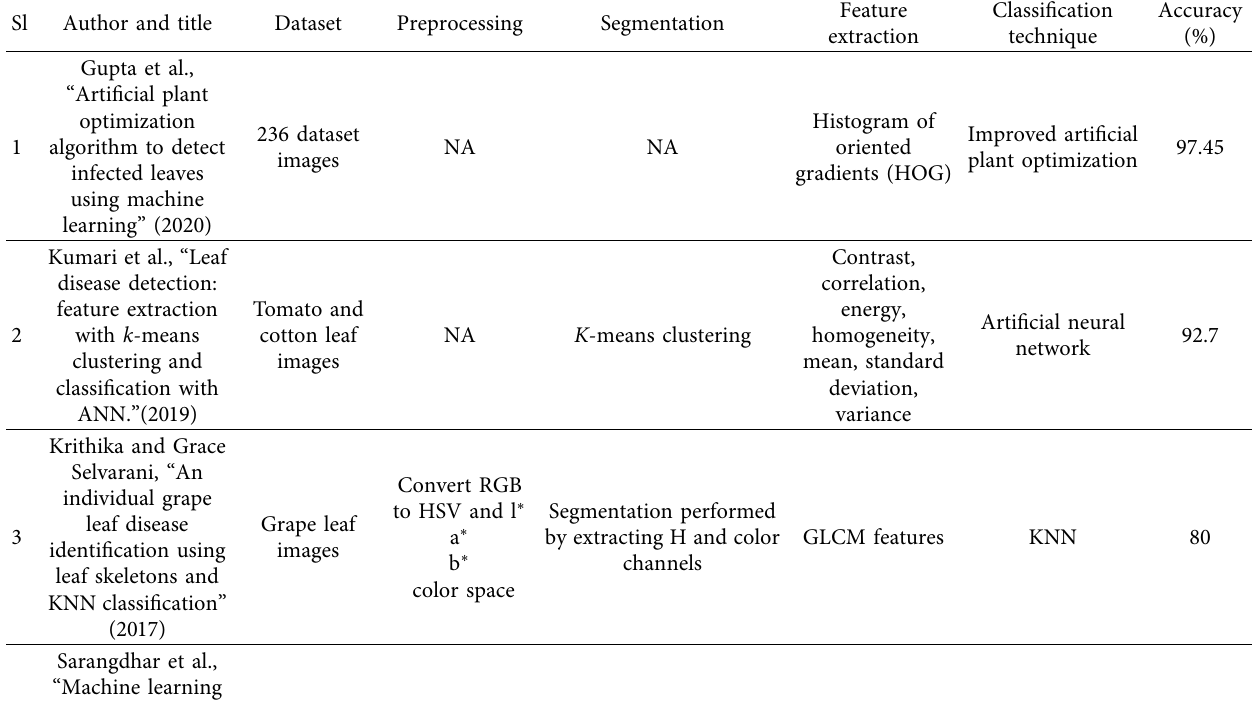
Table 1: Literature survey